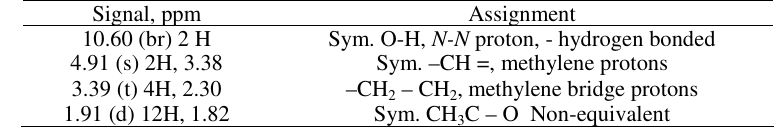
relative to tetramethylsilane as 3